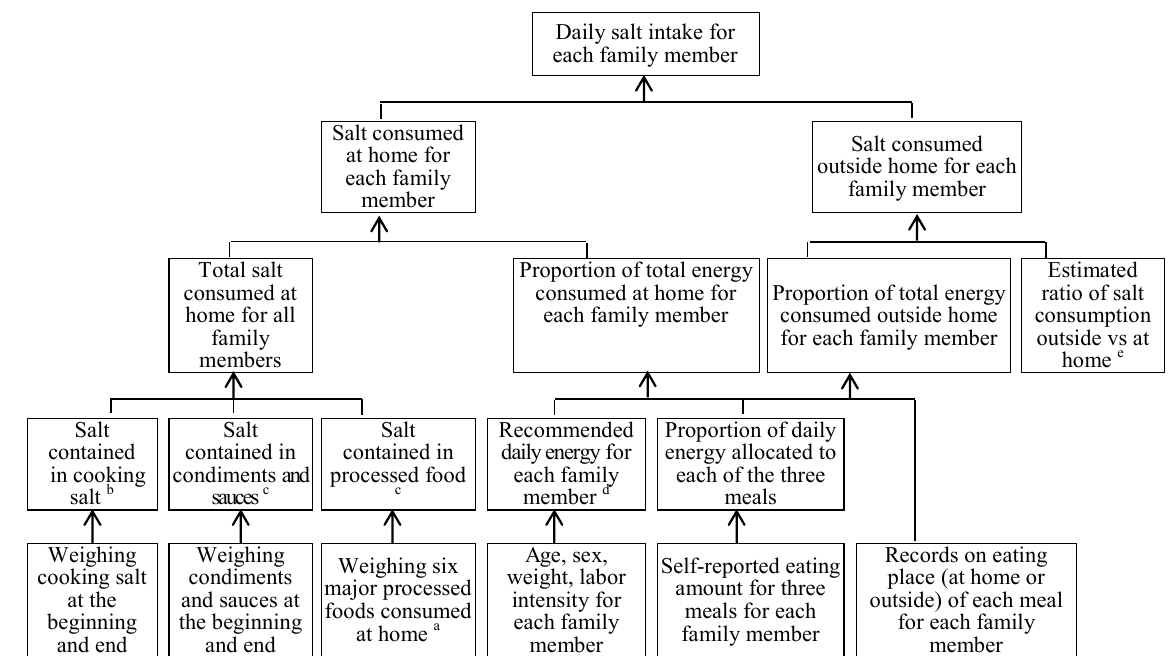
Figure 1 The pathway of the one-week salt estimation method in measuring individual salt intake